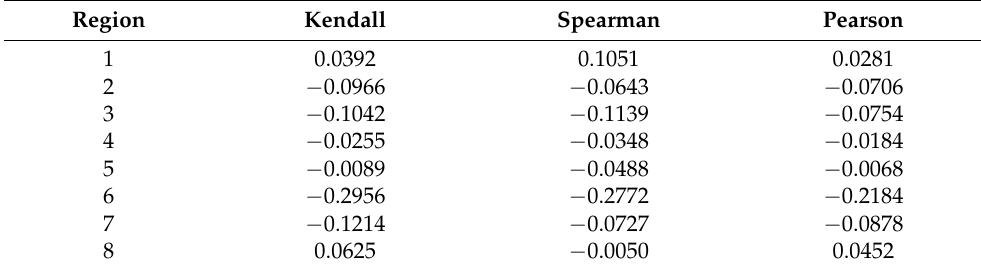
Table 4. The correlation coefficient in the selected regions. Region